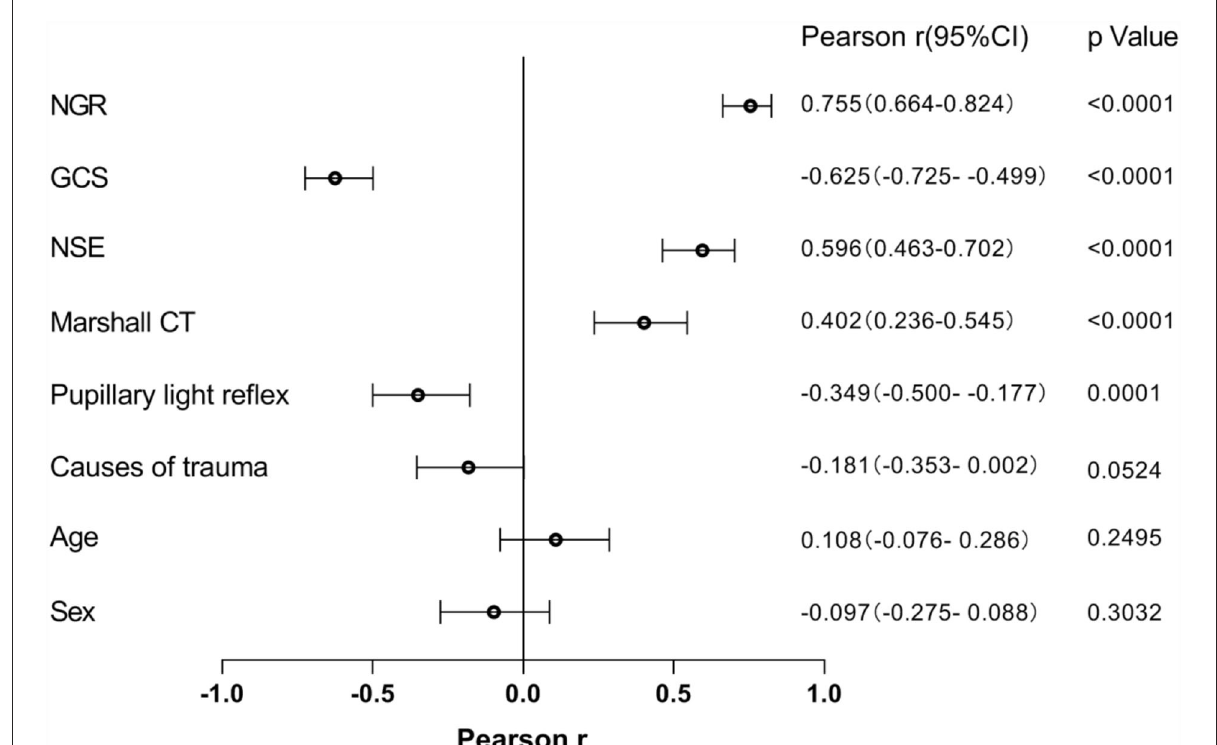
FIGURE2 The relationship between potential risk factors with the presence of DAI on clinical MRI. NSE, neuron-specific enolase; GCS, Glasgow Coma Scale; NGR, serum NSE level to admission GCS score